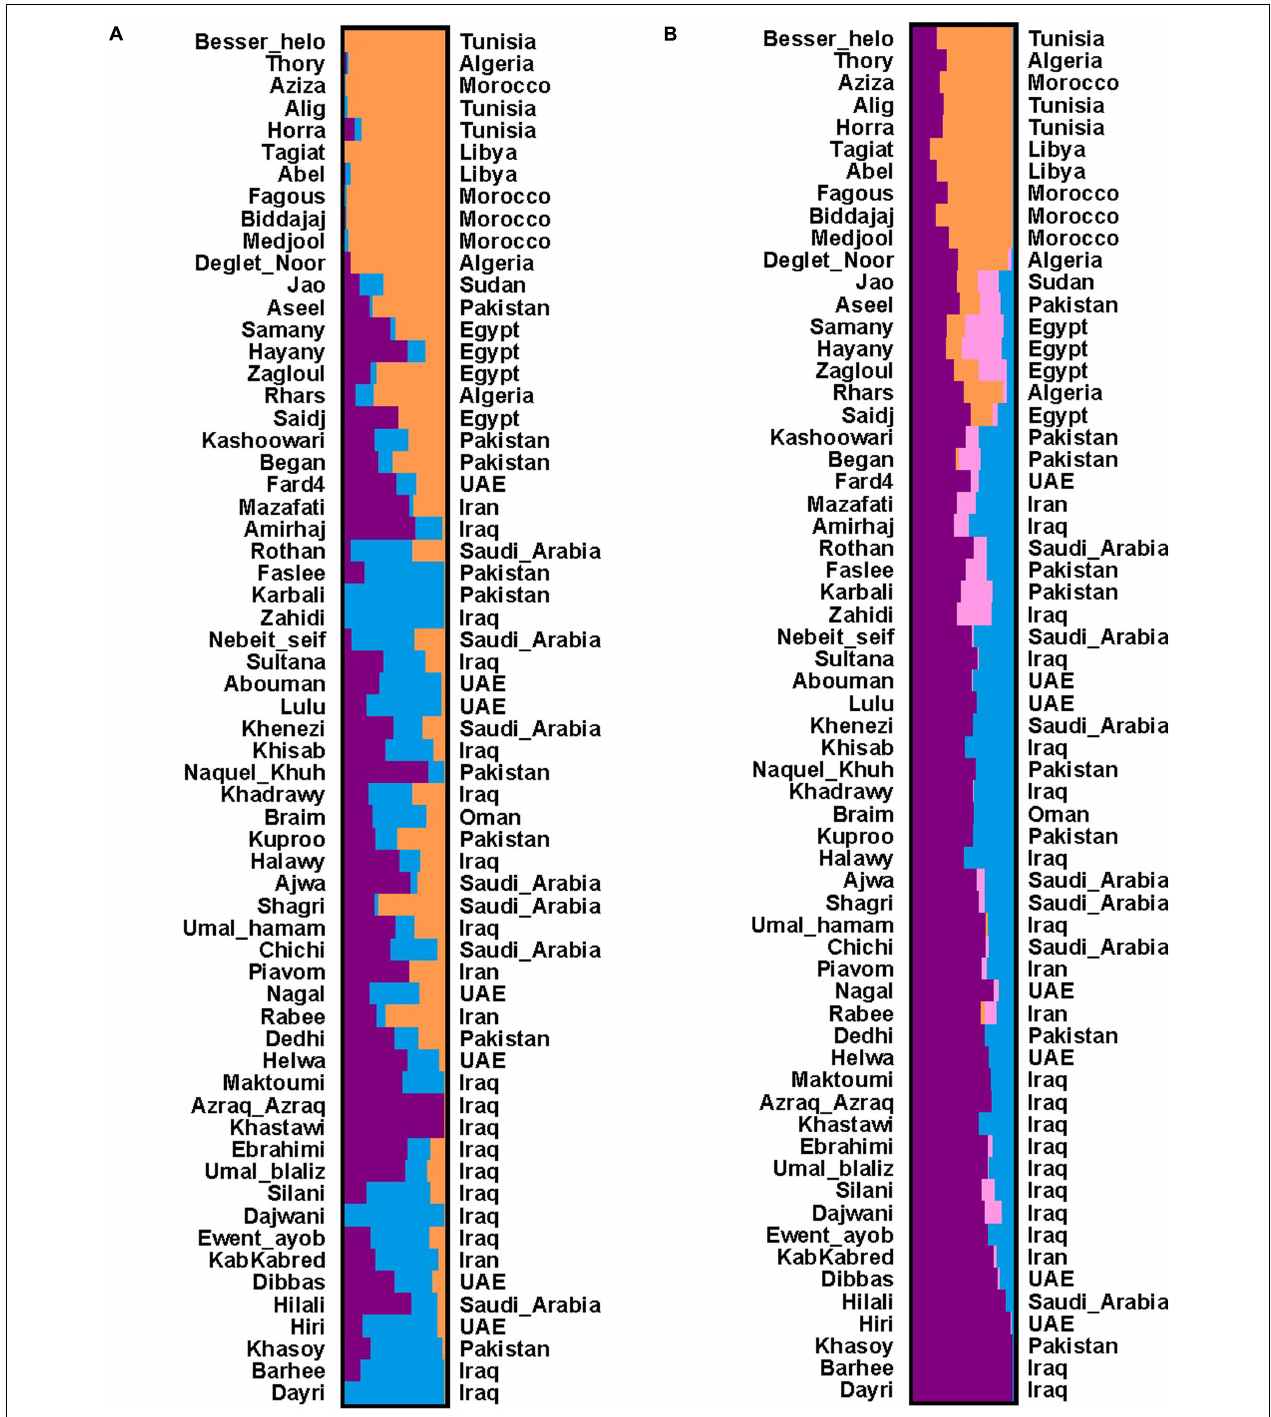
FIGURE 2 | (A) Population structure based on SNPs ( k = 3). The 62 date palm cultivars were grouped into three clusters. The color bar represents the component of ancestral origin. (B) Population structure based on SSRs ( k = 4). The 62 date palm cultivars were grouped into three clusters. The color bar represents the component of ancestral origin. The two clusters (Middle East and South Asia) are nearly same according to the geography locations among four SSR-based clusters. Thus, the SSR-based clusters are considered as three clusters.